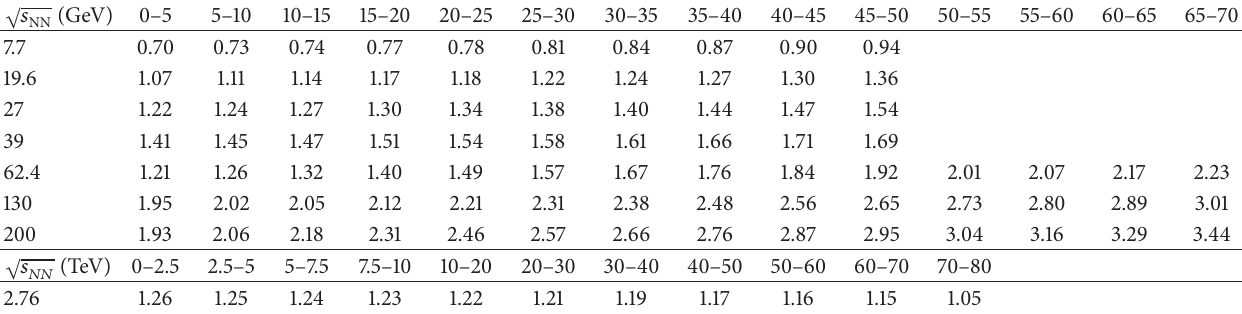
, the measure of collision centrality (shown in Figure 44). part